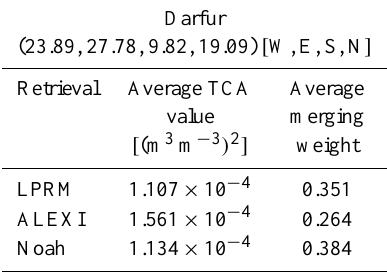
Table 1. Average merging weight and TC error values for the Ethiopian Highlands.